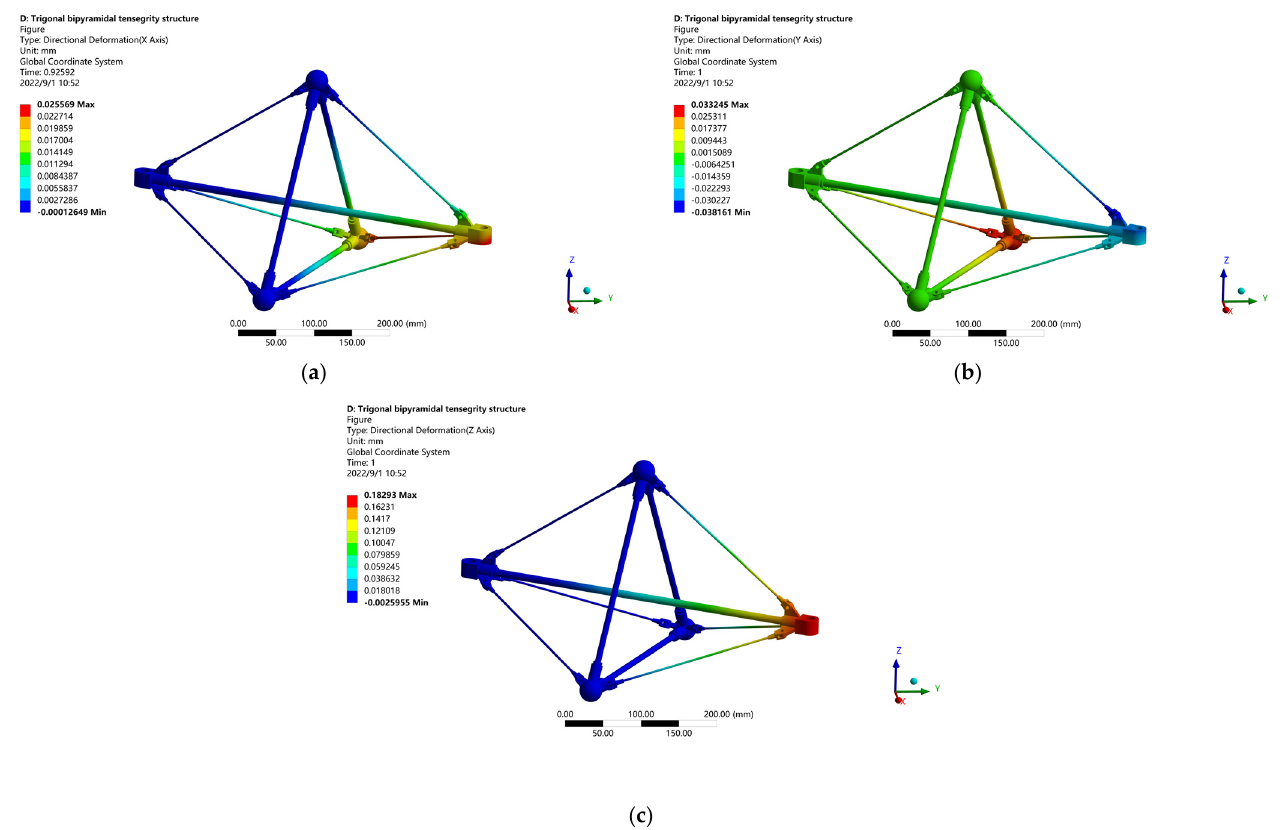
Figure 11. When the material is structural steel, simulation deformation of trigonal bipyramidal tensegrity structures in different coordinate directions: ( a ) x -axis; ( b ) y -axis; ( c ) z -axis. The deformation along the coordinate axis at nodes n 2 and n 5 can be expressed.